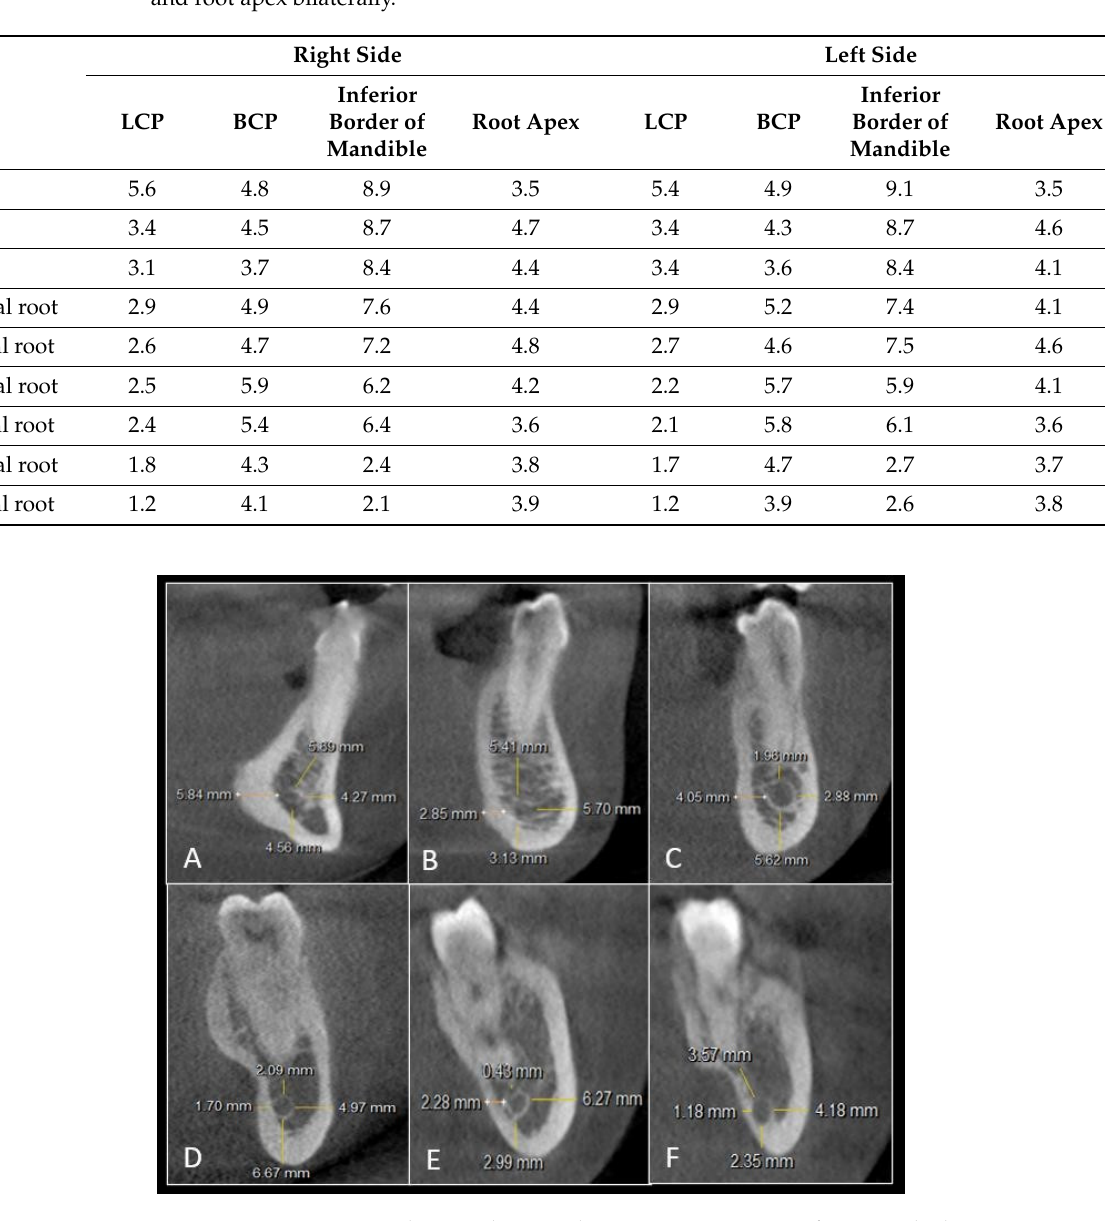
Figure 1. Cross-sectional view showing linear measurements of IAC with the root apex, BCP, inferior border of the mandible, and LCP in: ( A ) mandibular canine, ( B ) mandibular first premolar, ( C ) mandibular second premolar, ( D ) mandibular first molar, ( E ) mandibular second molar, and ( F ) mandibular third molar .